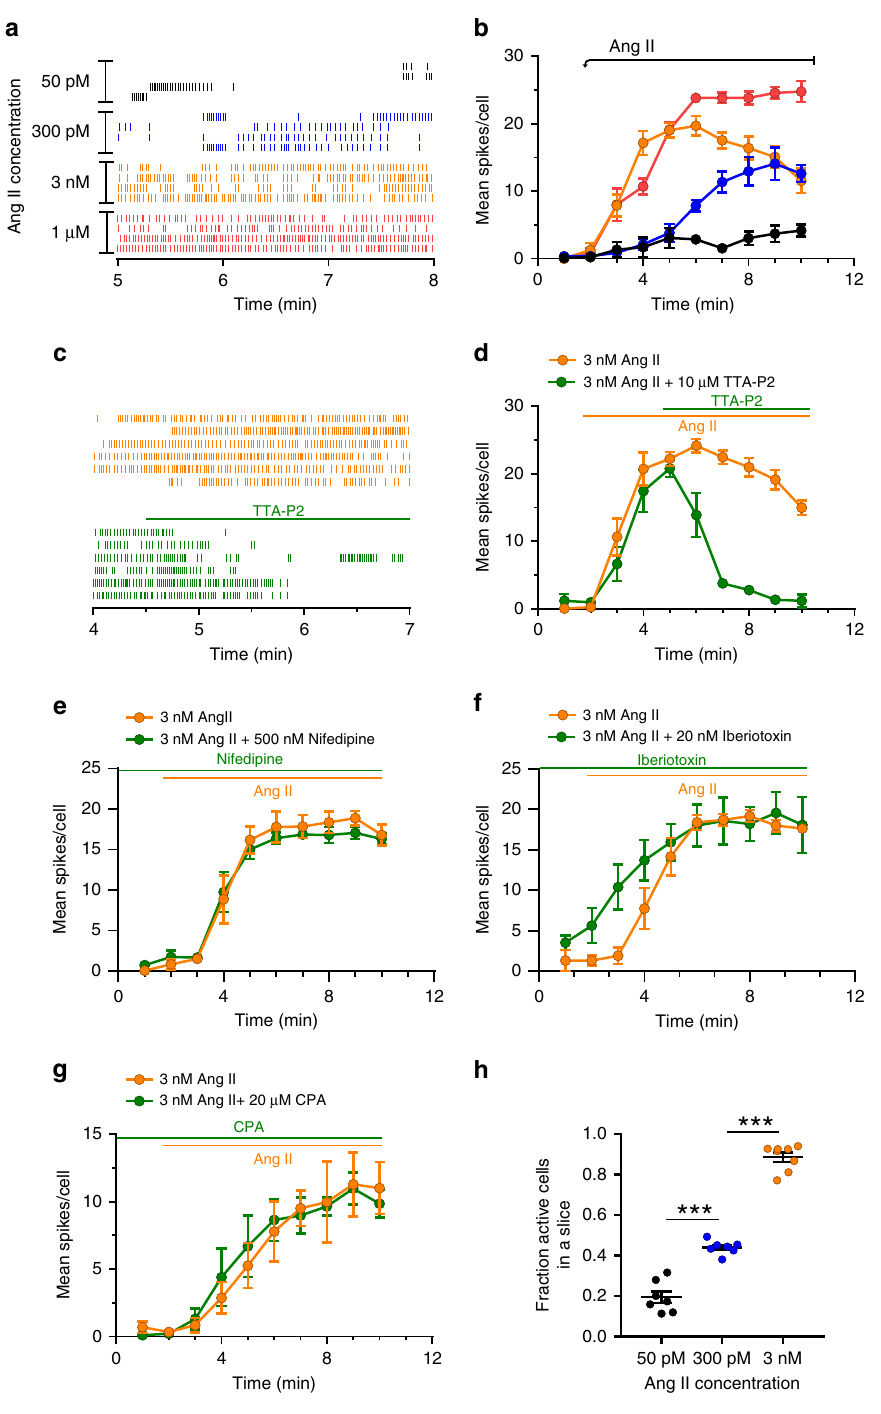
Figs. 1d, 3a) and a smaller, secondary population of spike inter- vals (>5 s) that re fl ected the duration of inactivity between two successive bursts. To capture the decay associated with the longer inter-burst intervals, the distribution was fi tted with the sum of a Gaussian and an exponential function. This model fi tting assumes that inter-spike intervals within a burst are normally distributed, whereas burst occurrence follows a Poisson process with an exponential inter-burst interval distribution. The intersection of these functions determined the threshold value (Fig. 3a, inset) that was used to separate (a) intra-burst calcium spike intervals